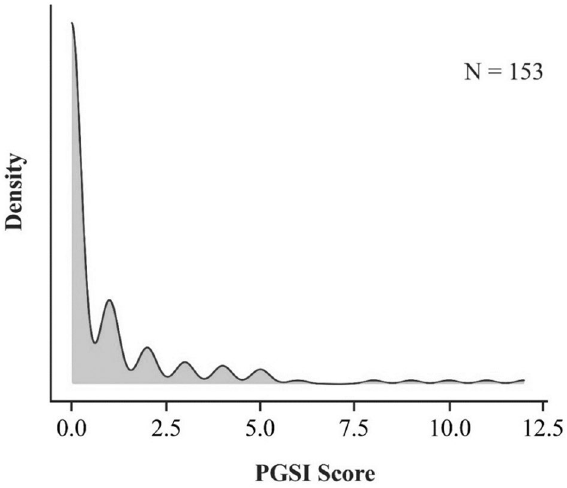
Figure 4. Density plot of PGSI score